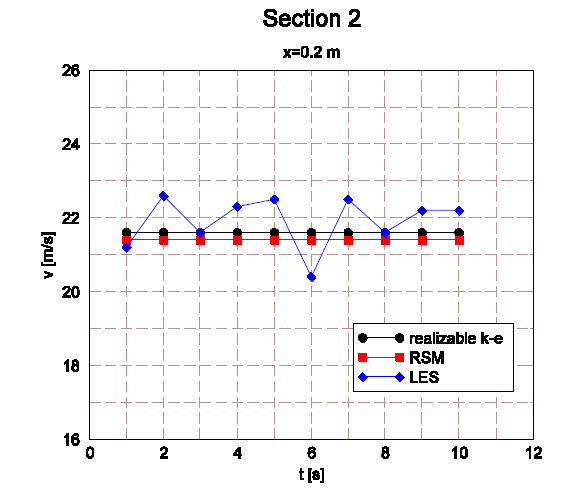
Figure 5. Velocity evolution in time for section 2 for the three turbu- lence models.